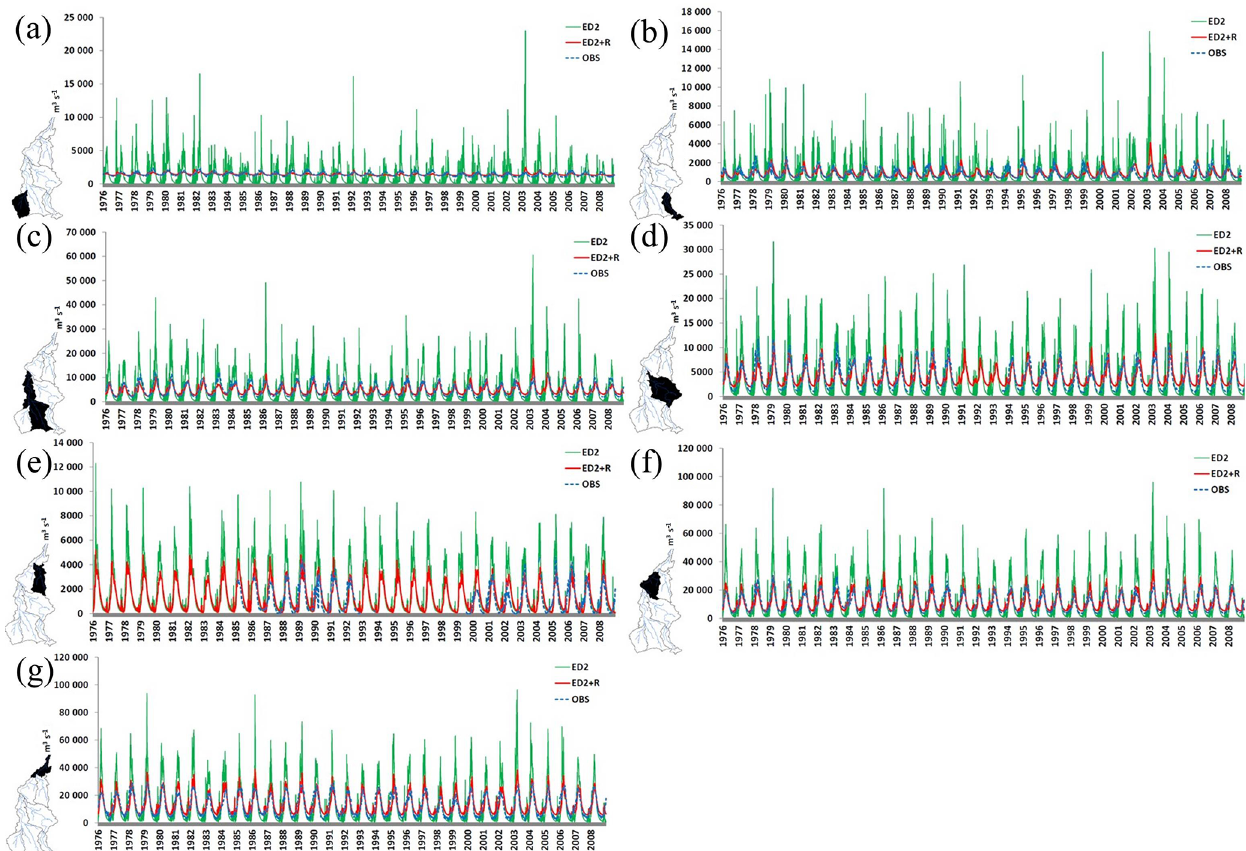
Figure A1. Time series of river flow (m 3 s − 1 ) at the outlet of each sub-basins. ED2 output (green line), ED2 + R (red line), and observations (blue dotted line). (a) Upper Juruena (UJ); (b) Upper Teles Pires (UTP); (c) Lower Juruena (LJ); (d) Lower Teles Pires (LTP); (e) Jamanxim (JA); (f) Upper Tapajós (UT); and (g) Lower Tapajós